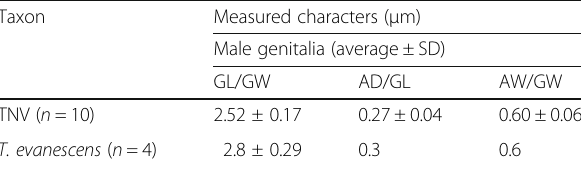
Table 4 Measured characters ( μ m) of TNV and T. evanescens male genitalia